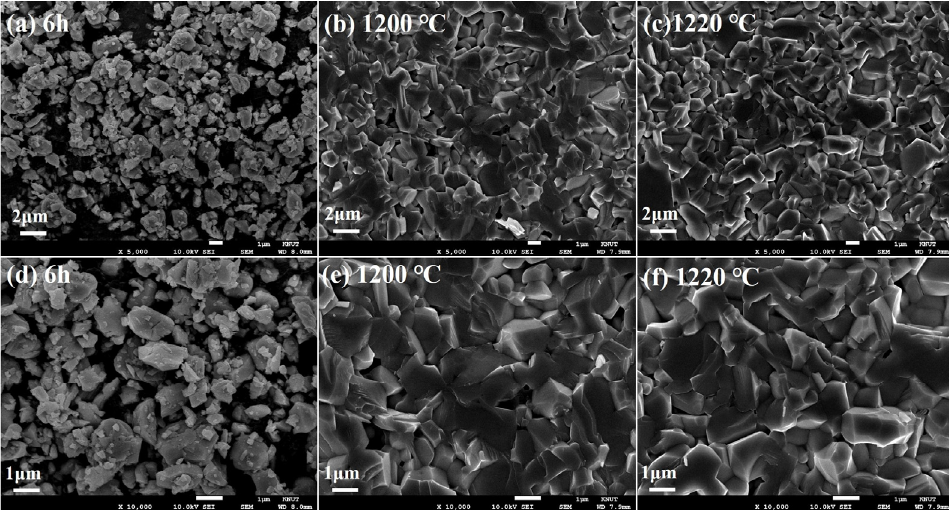
Figure 6. ( a – f ) SEM micrographs of Sr 0.4 Ca 0.3 La 0.3 Fe 10.2 Co 0.1 Mn 0.1 Si 0.05 Mg 0.05 O 19 ( y = 1.0) sintered samples: ( a , d ) after an additional 6 h of ball-milling and after subsequent sintering at ( b , e ) 1200 °C and ( c , f ) 1220 °C at low and high magnification.